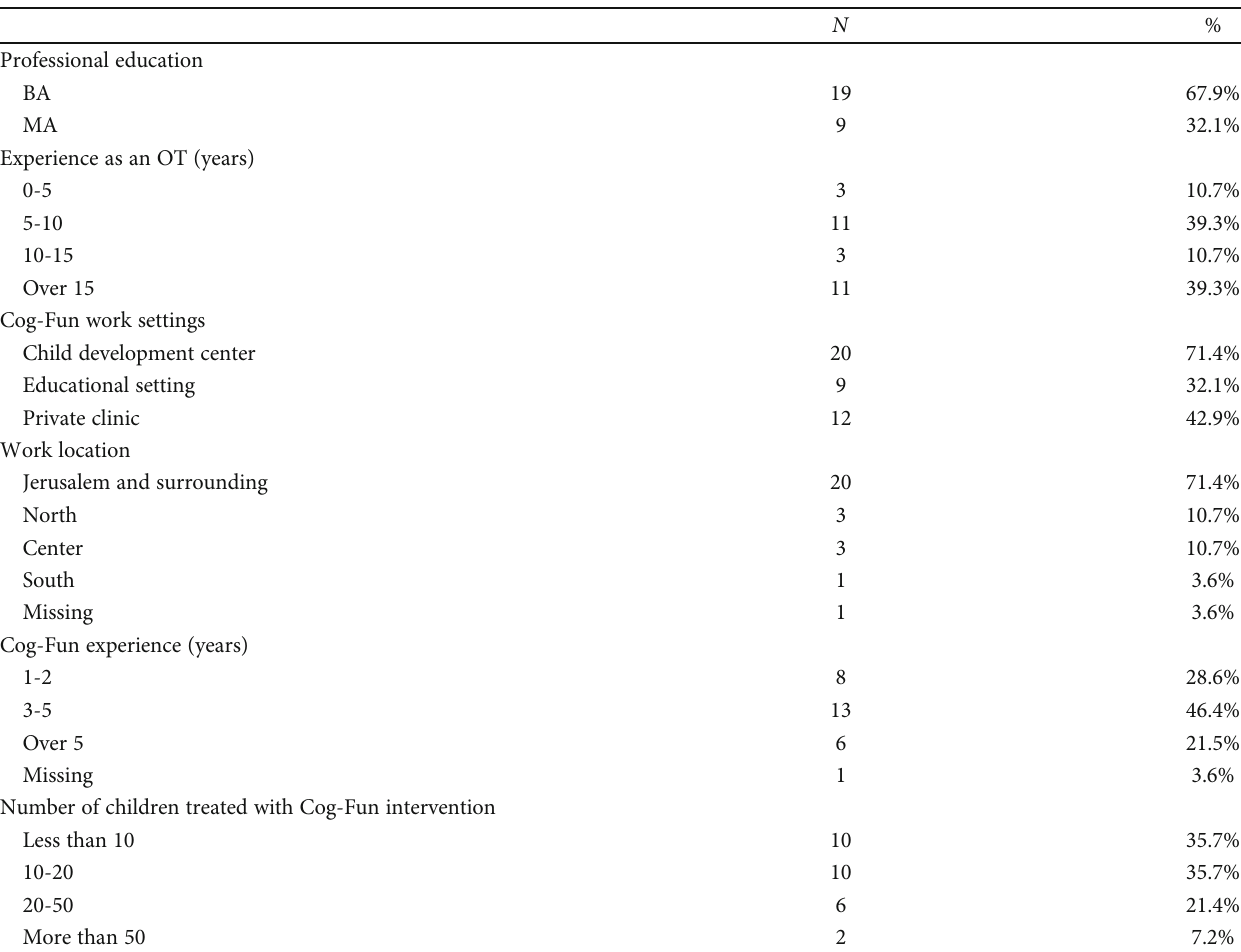
Table 1: Participant professional characteristics ( N = 28